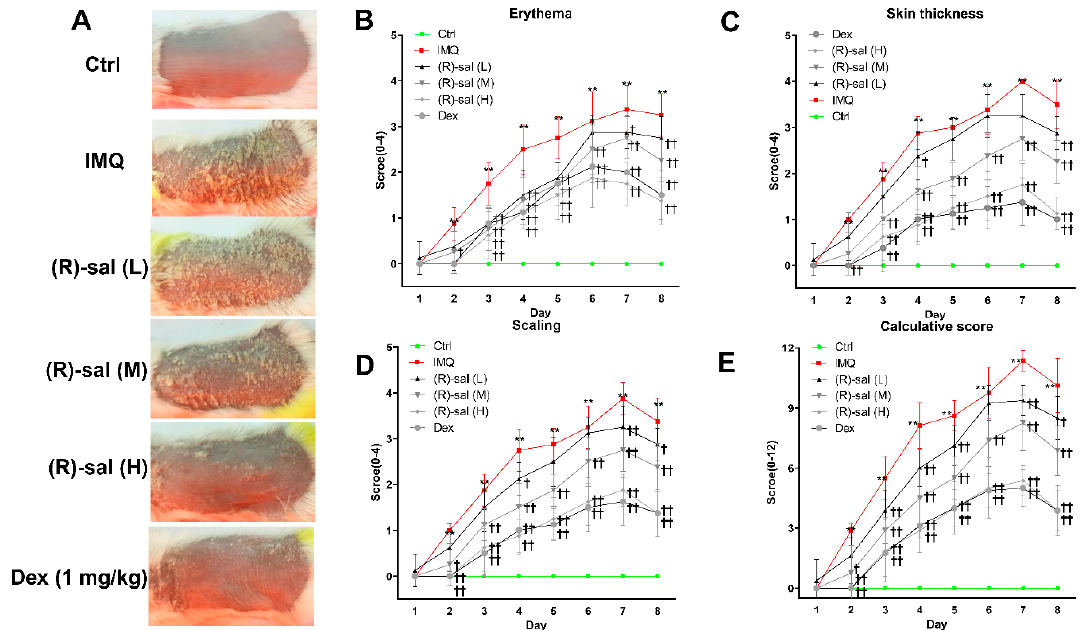
Figure 2. ( R )-salbutamol alleviates psoriatic dermatitis. Phenotypical presentation of mouse back skin from control, IMQ, ( R )-salbutamol and Dex groups after seven days of treatment, respectively ( A ). Distinct levels of erythema ( B ), skin thickeness ( C ), scaling ( D ) of back skin was scored daily on a scale from 0 to 4. Additionally, the cumulative score ( E ) (erythema plus scaling plus thickness) is depicted. n = 8, Mean ± SD, † p < 0.05, †† p < 0.01 vs. IMQ group, ** p < 0.01 vs. control group.